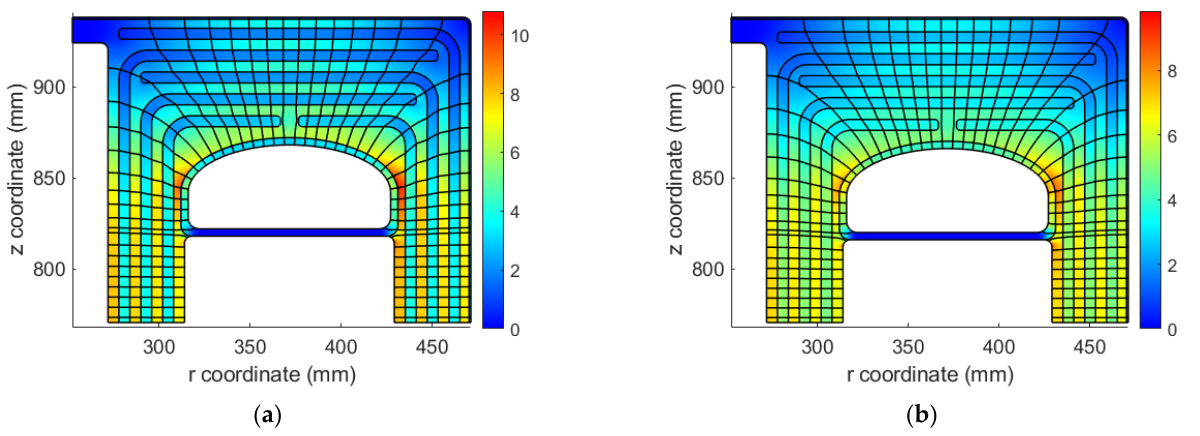
Figure 7. The initial permittivity-based stress distribution in kV/mm and the electric field streamlines in the dielectric structure of the MFT using: ( a ) mineral oil; ( b ) ester oil.